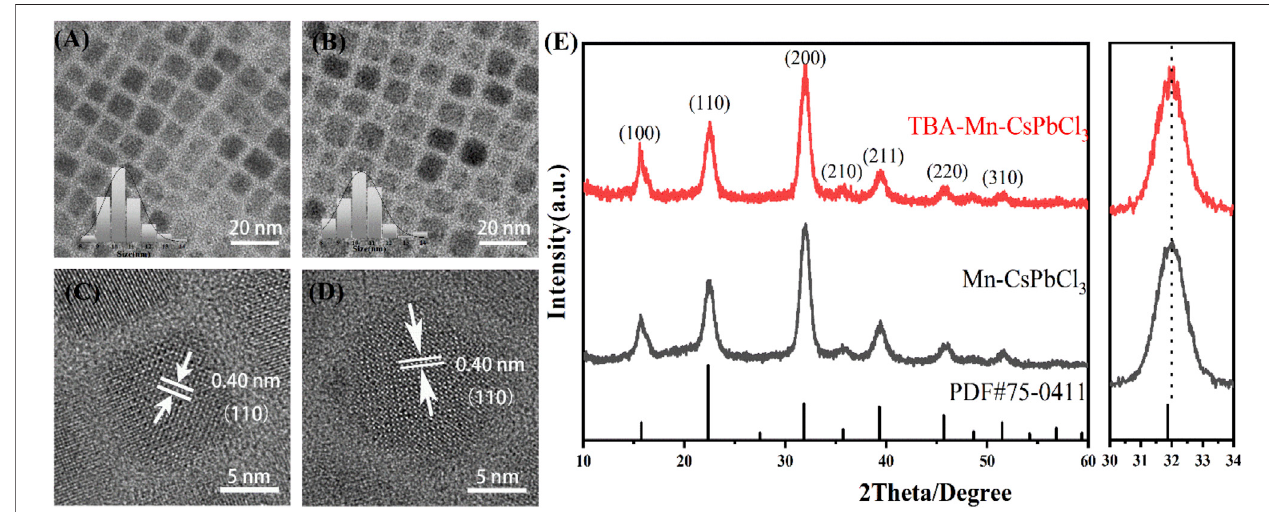
FIGURE 1 | (A) TEM and (C) HRTEM images of CPCM NCs. (B) TEM and (D) HRTEM images of CPCM-TBA NCs. The insets of (A) and (C) are the histograms of particle size distribution. (E) XRD patterns of CPCM and